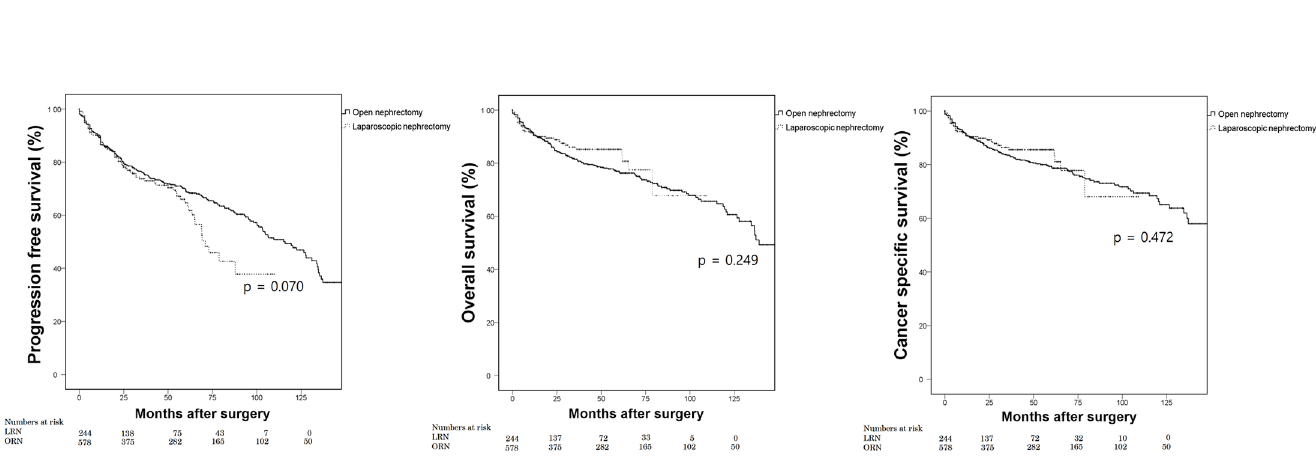
Fig 1. Kaplan-Meier analysis of progression-free, overall, and cancer-specific survival according to surgery type.